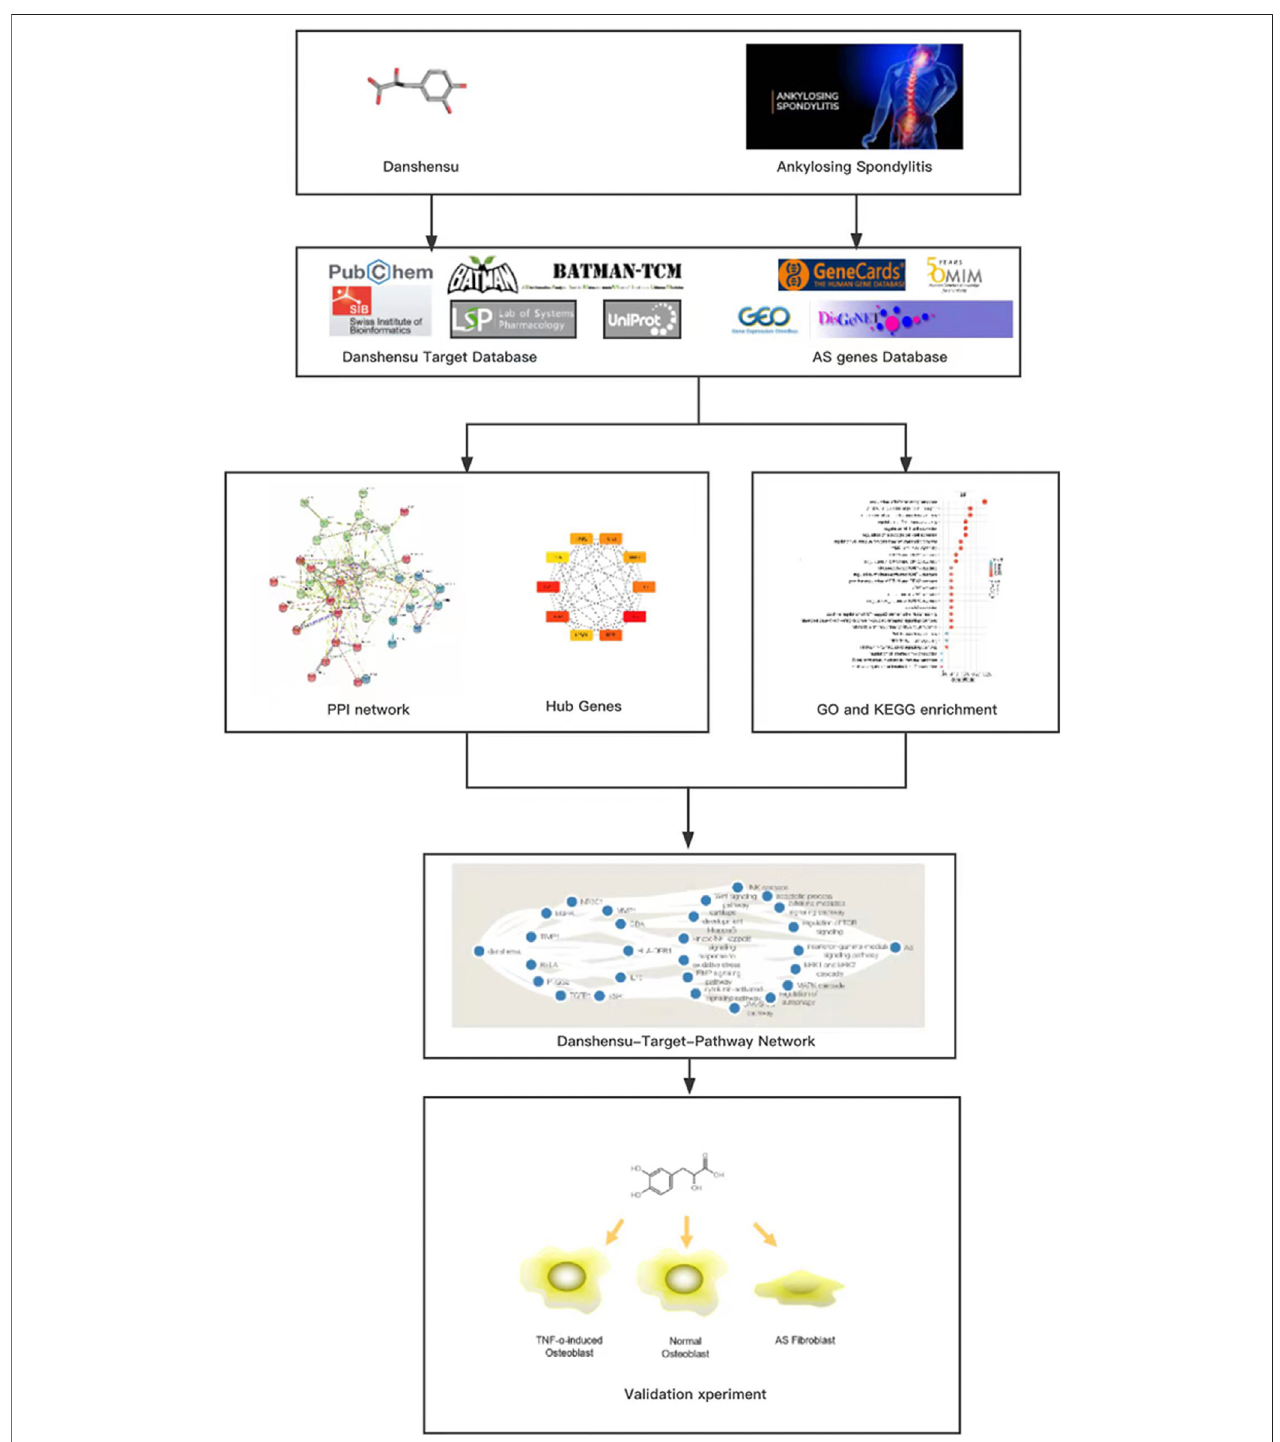
FIGURE 1 | Work fl ow of systems pharmacology analysis and experimental assessment.